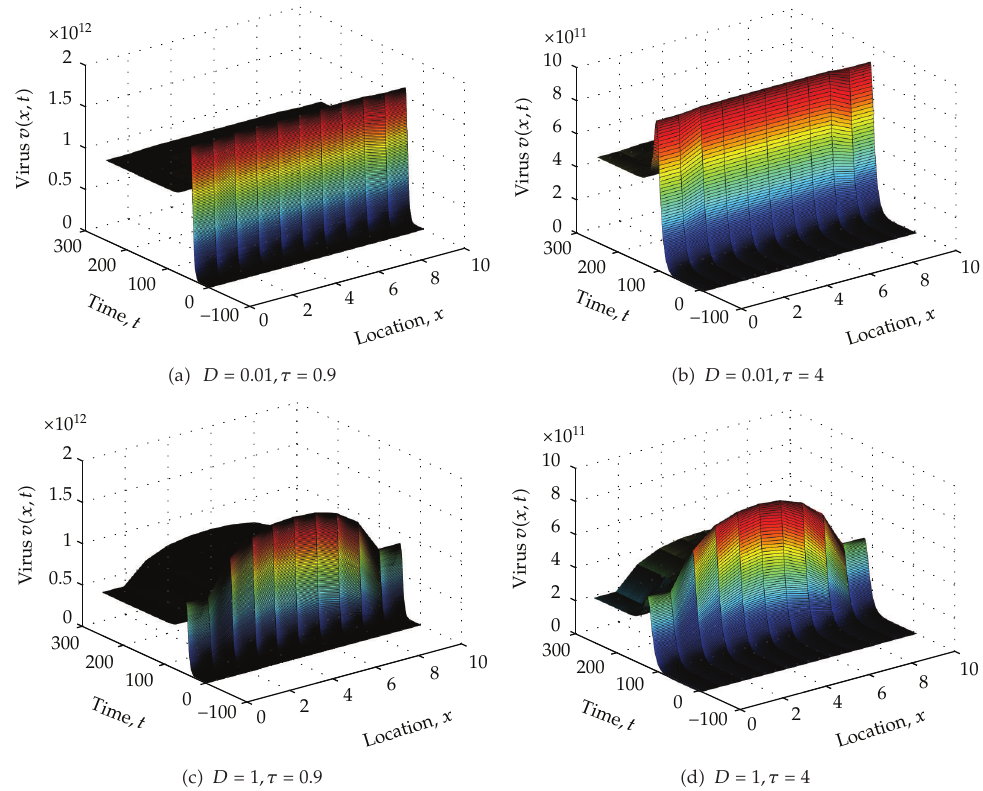
Figure 4: In this case the parameter are L (cid:8) 2 7 , d (cid:8) 3 . 78 − 2 , a (cid:8) 3 . 38 d , p (cid:8) 0 . 67, β (cid:8) 1 . 45 − 4 , k (cid:8) 5 . 18 3 and m (cid:8) 0 .